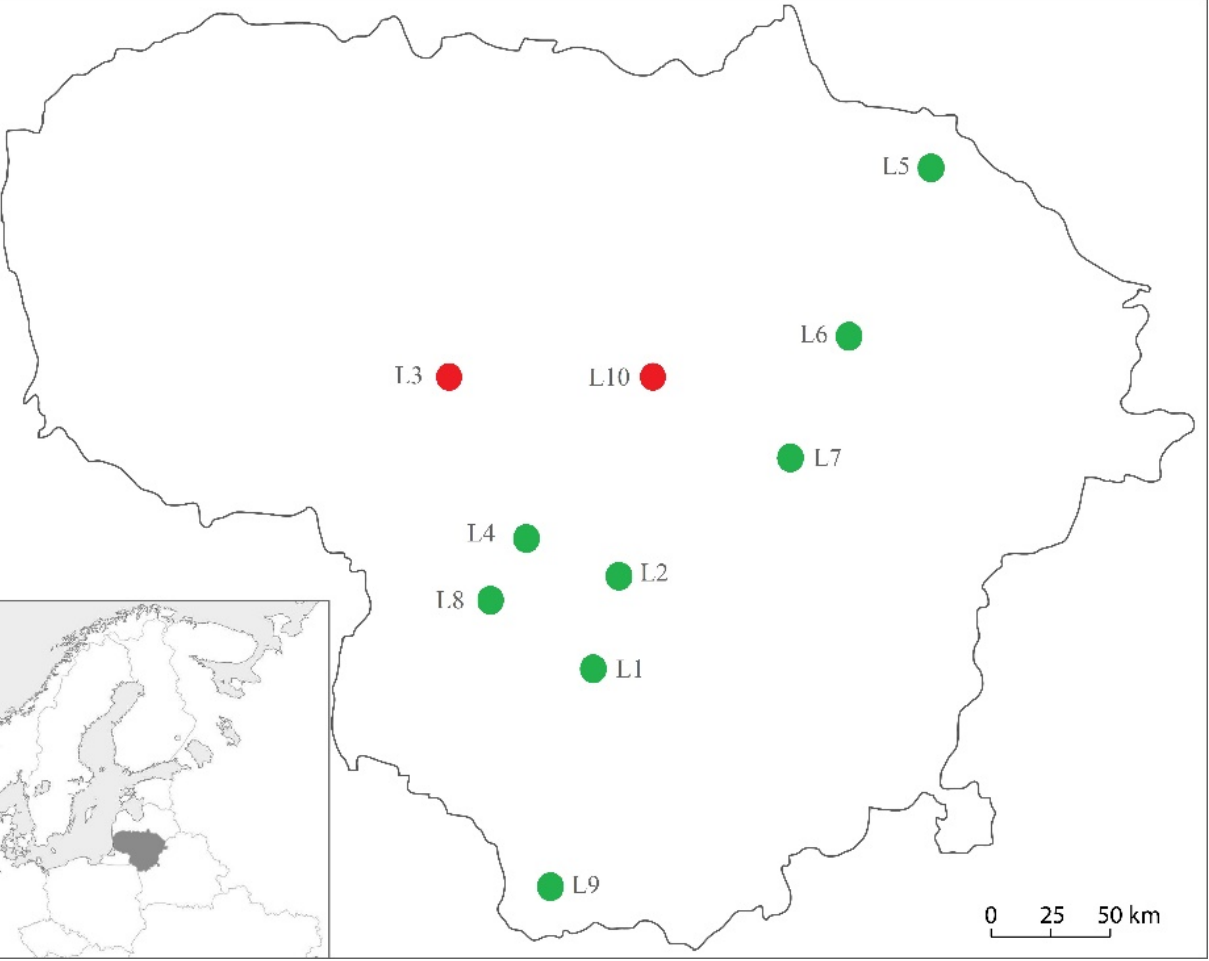
Figure 1. Map of Lithuania showing investigated Larix spp. stands (L1-L10): red circles indicate the presence of T. gabrieli , and green circles—its absence.